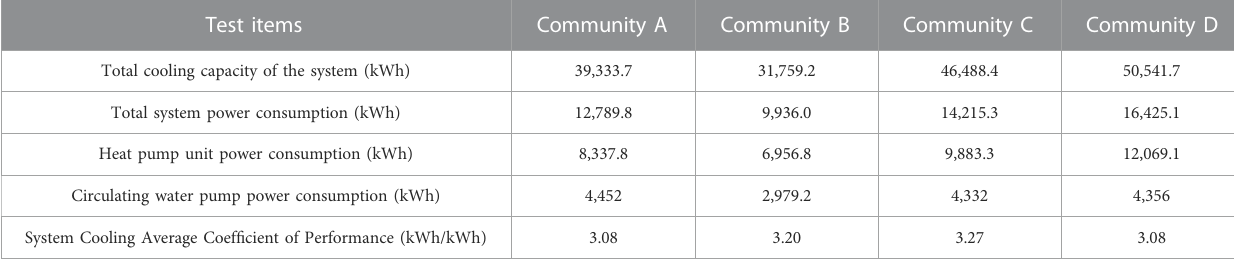
TABLE 4 Performance test results of heat pump system under actual operating conditions. Test